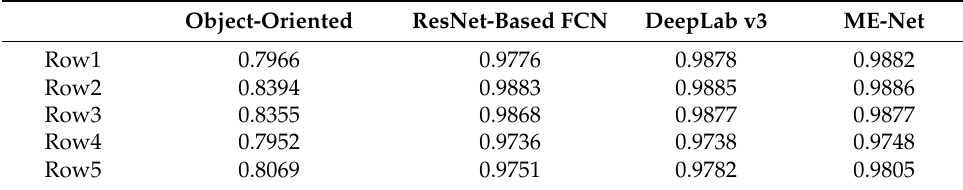
Figure 14. Performance of different pixel classification models in mangrove extraction. The first column ( a ) shows the actual color of the remote sensing imagery; the second column ( b ) shows the corresponding ground reality; the third column ( c ) shows the prediction result of object-oriented by ENVI; the fourth column ( d ) shows the prediction result of ResNet-based FCN model; the fifth column ( e ) shows the prediction result of DeepLab v3 model; the sixth column ( f ) shows the prediction result of the ME-Net model. Green, red, blue, and black represent the TP, FP, FN, and TN, respectively. Table 10. The IoU for data in Figure 14 from rows 1 to